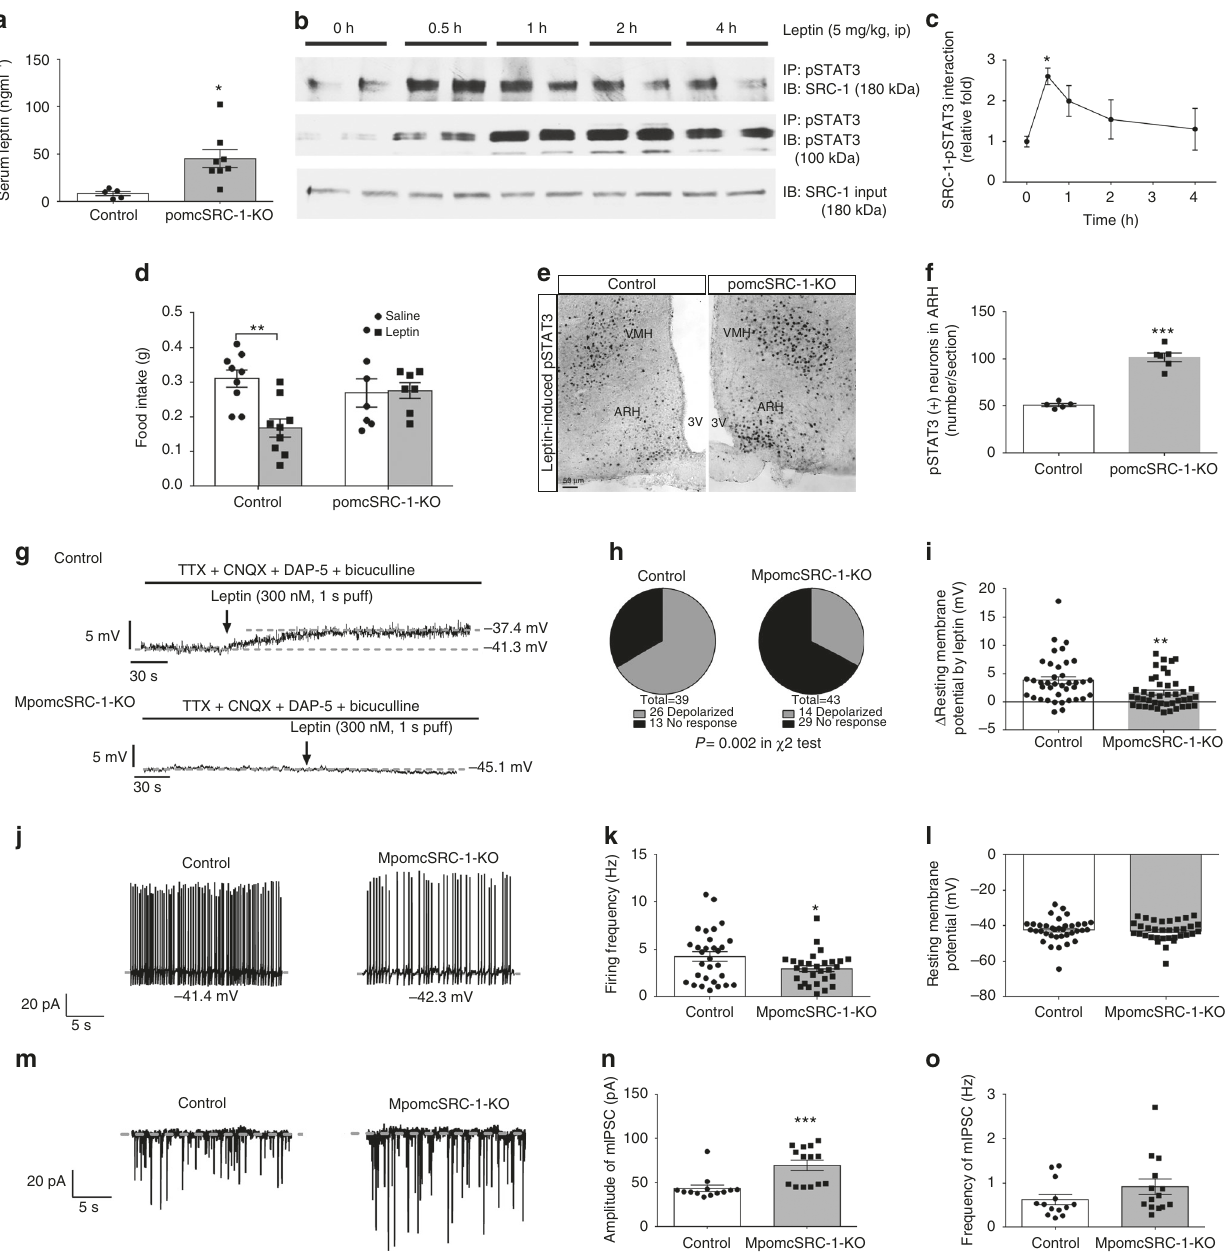
Fig. 2 SRC-1 mediates leptin signaling. Numbers of mice/experiments/neurons are indicated; data are presented as mean ± SEM and compared using T -tests or one- or two-way ANOVA followed by post hoc Sidak tests (#). a Serum leptin levels 42 days after HFD feeding ( n = 5/8); * P < 0.05. b Time course of hypothalamic SRC-1-pSTAT3 interaction in C57Bl6 wild type mice that received i.p. injections of leptin (5 mg/kg). c Quanti fi cation of the hypothalamic SRC-1-pSTAT3 interaction. * P < 0.05 (#). d Two-hour fasted mice (12 weeks of age) received i.p. injections of saline or leptin (5 mg/kg) 15 min prior to refeeding and food intake was recorded for 1 h afterwards ( n = 7/9); ** P < 0.01 (#). e Representative pSTAT3 immunohistochemical staining in the ARH and VMH of control and pomcSRC-1-KO mice receiving a single bolus i.p. injection of leptin (0.5 mg/kg, 90 min). Scale bar = 50 μ m. 3V the 3rd ventricle, ARH arcuate nucleus, VMH ventromedial hypothalamic nucleus. f Quanti fi cation of pSTAT3 ( + ) neurons in the ARH ( n = 5); *** P < 0.001. g Representative traces of leptin-induced depolarization, in the presence of TTX, CNQX, DAP-5, and bicuculline, in mature Pomc neurons from control mice vs. from MpomcSRC-1-KO mice after 1-week HFD feeding. h Responsive ratio (depolarization is de fi ned as >2 mV elevations in resting membrane potential) ( n = 39/43); P = 0.002 in χ 2 tests. i Quanti fi cation of leptin-induced depolarization in two groups ( n = 39/43); ** P < 0.01. j Representative traces of action potentials in untreated mature Pomc neurons from control mice vs. from MpomcSRC-1-KO mice. k , l Quanti fi cation of fi ring frequency ( k ) and resting membrane potential ( l ) in two groups ( n = 29 – 36); * P < 0.05. m Representative traces of mIPSC in untreated mature Pomc neurons from control mice vs. from MpomcSRC-1-KO mice. n , o Quanti fi cation of amplitude ( n ) and frequency ( o ) of mIPSC in two groups ( n = 13/14); *** P < 0.001. Source data are provided as Source Data Fig.